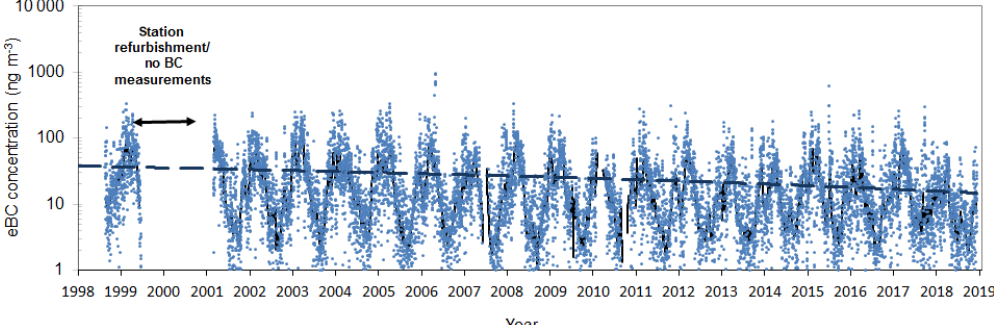
Figure 5. Equivalent black carbon concentration time series obtained by a seven-wavelength aethalometer at Zeppelin Station. (Data before 2000 are obtained by an AE-9 aethalometer.)